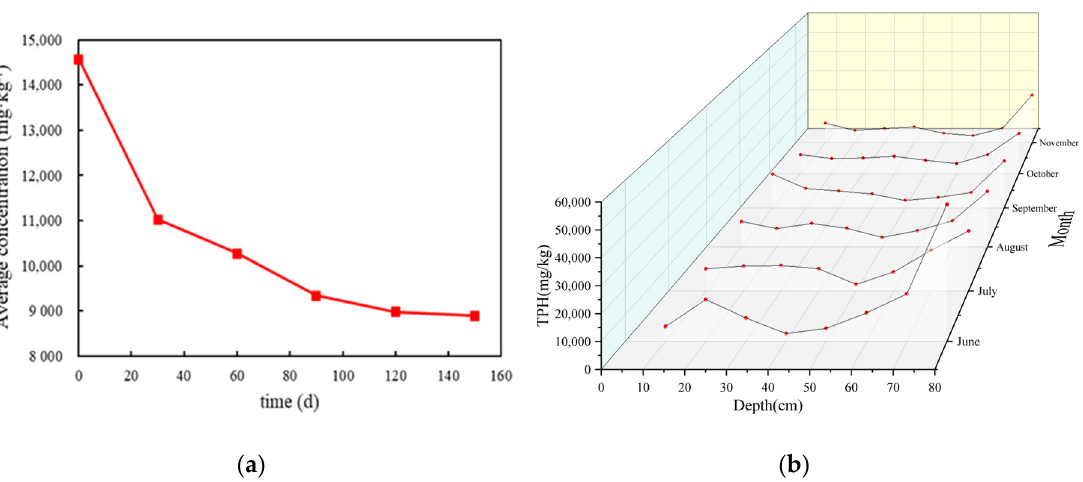
Figure 10. ( a ) Variation in the TPH average concentration and ( b ) monthly concentrations of different points in the M-C-M tank.